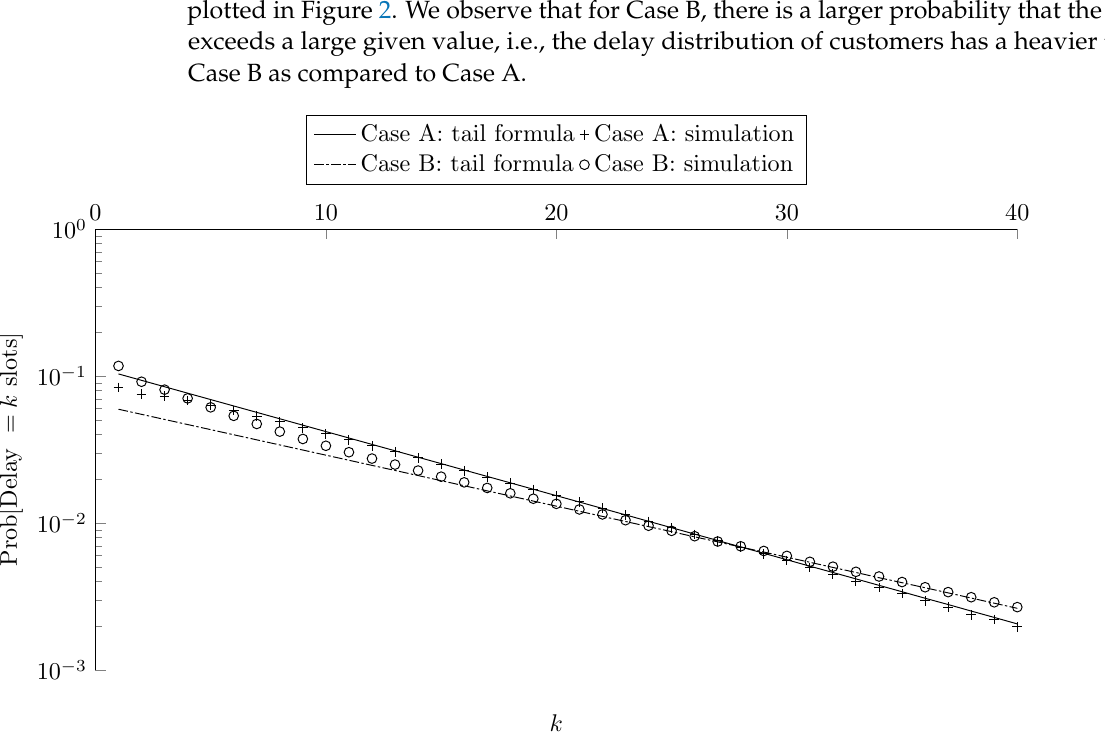
Figure 2. Distribution of delay for Case A and Case B both based on the theory of this paper (tail distribution) and based on simulation (probability mass